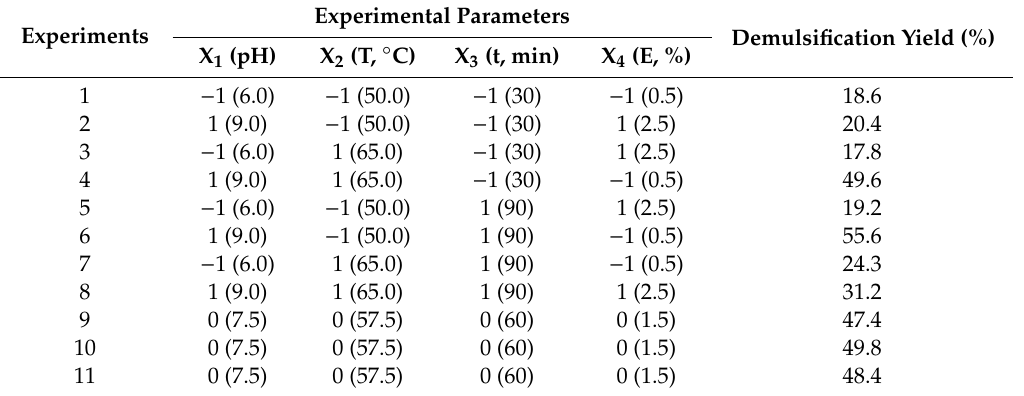
Table 1. E ff ects of pH, temperature, reaction time, and amount of enzyme on cream demulsification yield using a fractional factorial design.